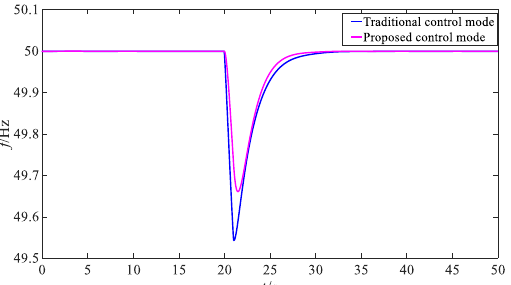
Figure 11. Frequency variation in different control modes under short circuit fault.